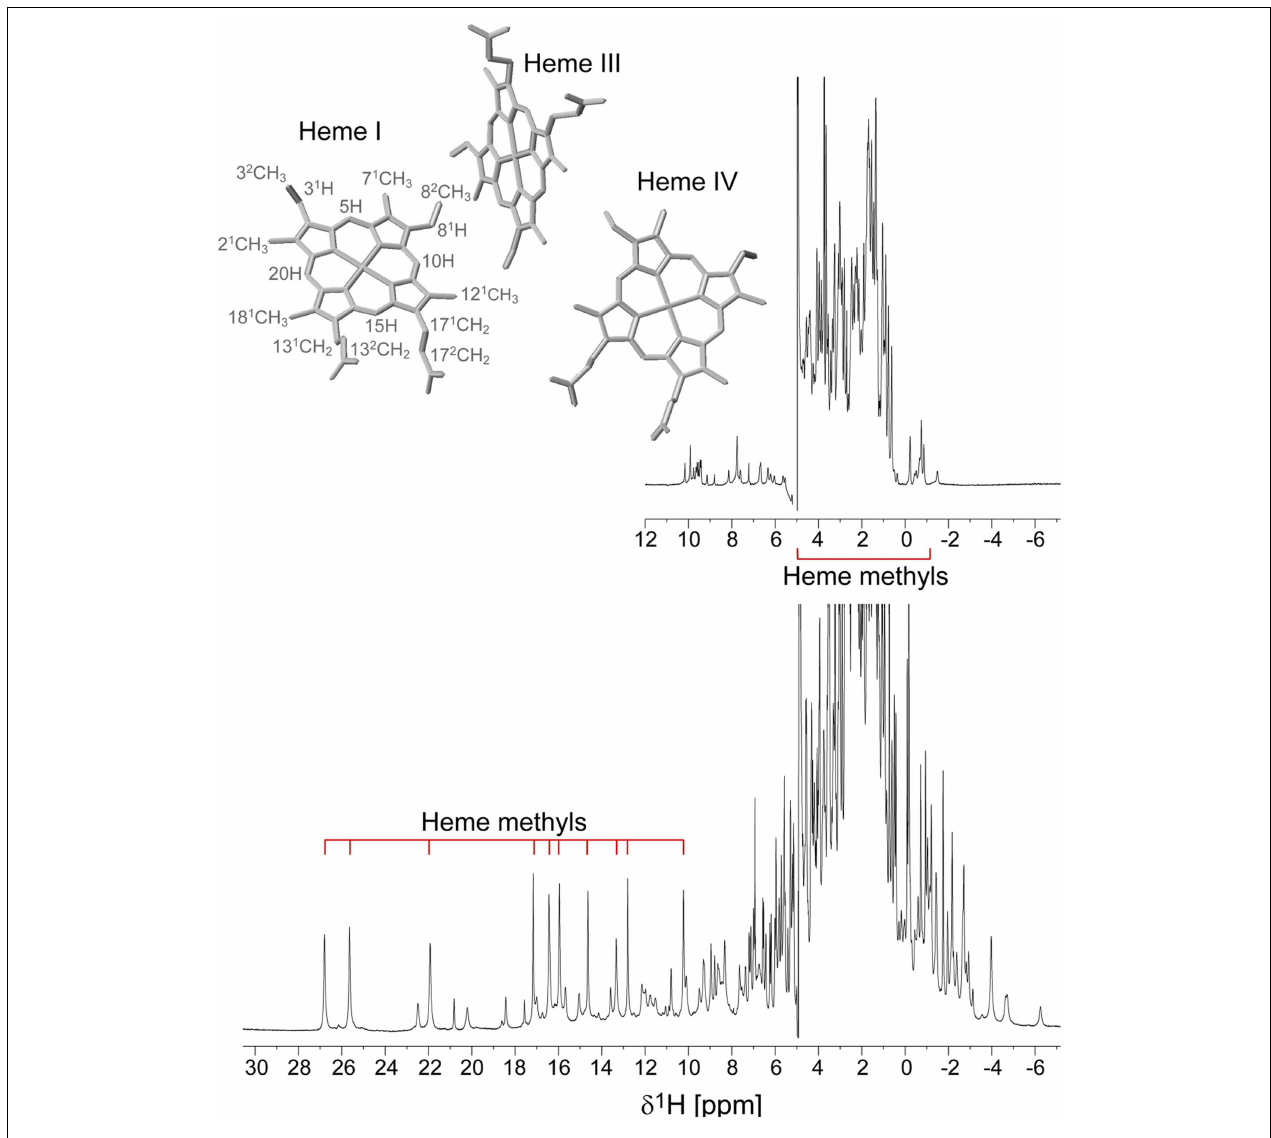
FIGURE 4 | 1D 1 H NMR spectra of the reduced (upper spectrum) and oxidized (lower spectrum) cytochrome PpcD (298 K). The typical regions of the heme methyl signals are indicated. In the oxidized spectrum the heme methyl signals are in the following order from left to right: 2 1 CH I 3 ,